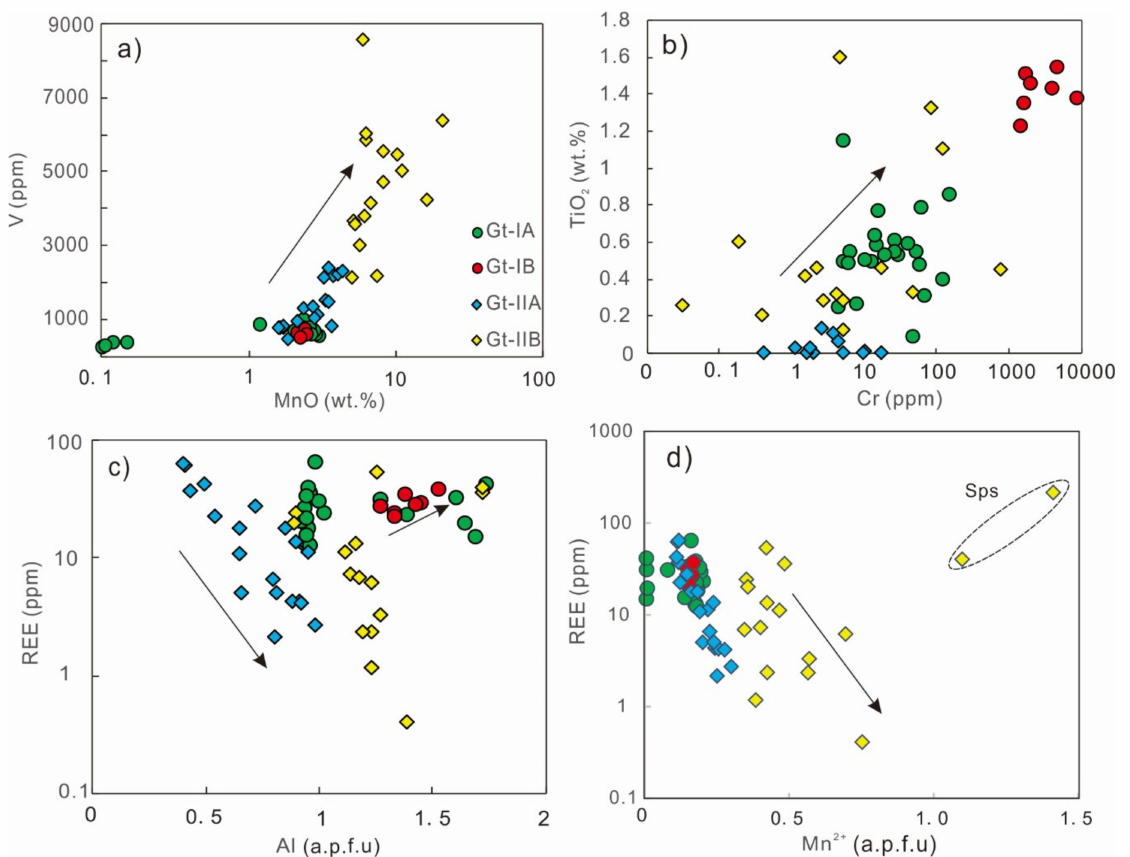
Figure 9. Correlation diagrams of V-Mn, Cr-Ti, Al-REE and Mn-REE of di ff erent types of garnets from the Zhuxiling W (Mo) deposit. And ( a – d ) represents MnO (%) versus V (ppm), Cr (ppm) versus TiO 2 (%), Al (a.p.f.u) versus REE (ppm), and Mn 2 + (a.p.f.u) versus REE (ppm) plot